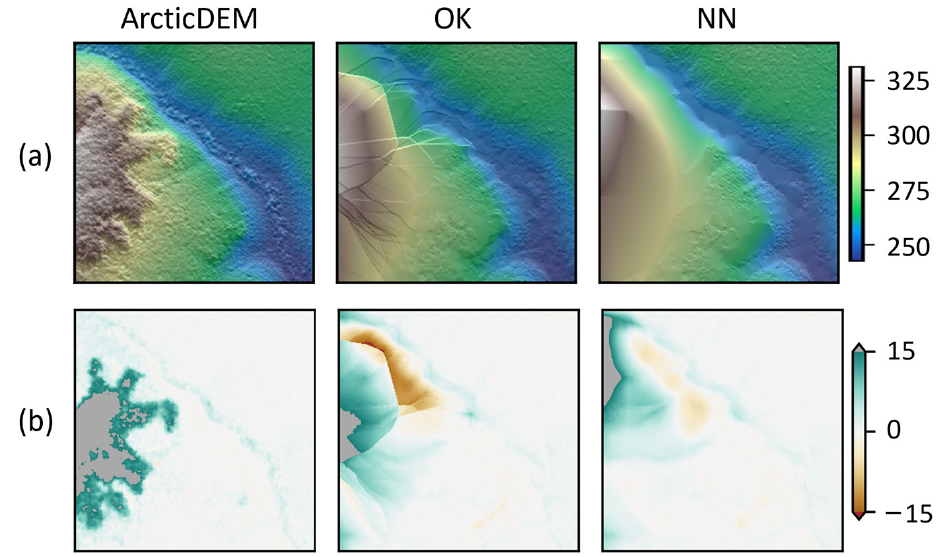
Figure 8. ArcticDEM and DTM interpolation at Site-2: ( a ) ArcticDEM, DTMs predicted by OK and NN spatial interpolation techniques, and ( b ) elevation difference maps between ArcticDEM, the predicted DTMs and the reference lidar-derived DTMs.